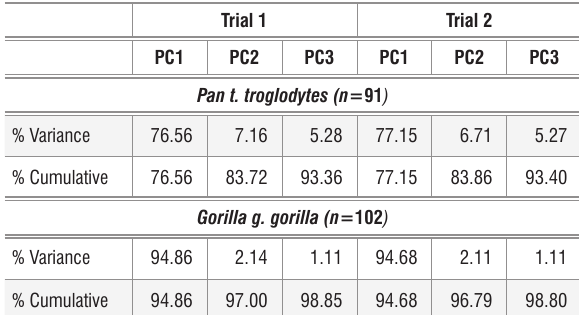
Summary statistics for the principal components (PC)